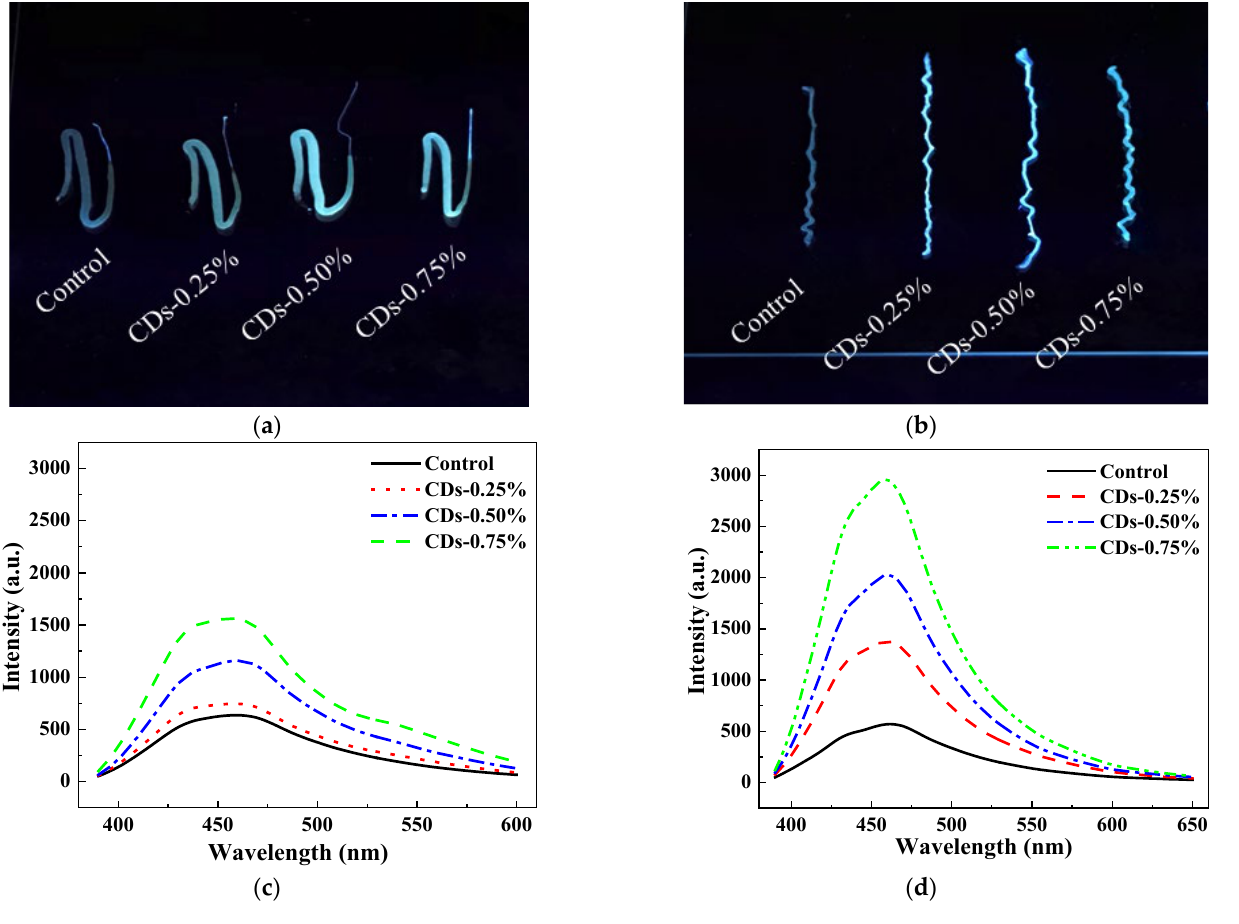
Figure 6. Effect of CDs on the fluorescence intensity of silk glands. ( a , b ) UV pictures of ( a ) the middle and ( b ) posterior silk glands. ( c , d ) PL spectra of ( c ) the middle and ( d ) posterior silk glands (measured with an excitation wavelength of 370 nm).